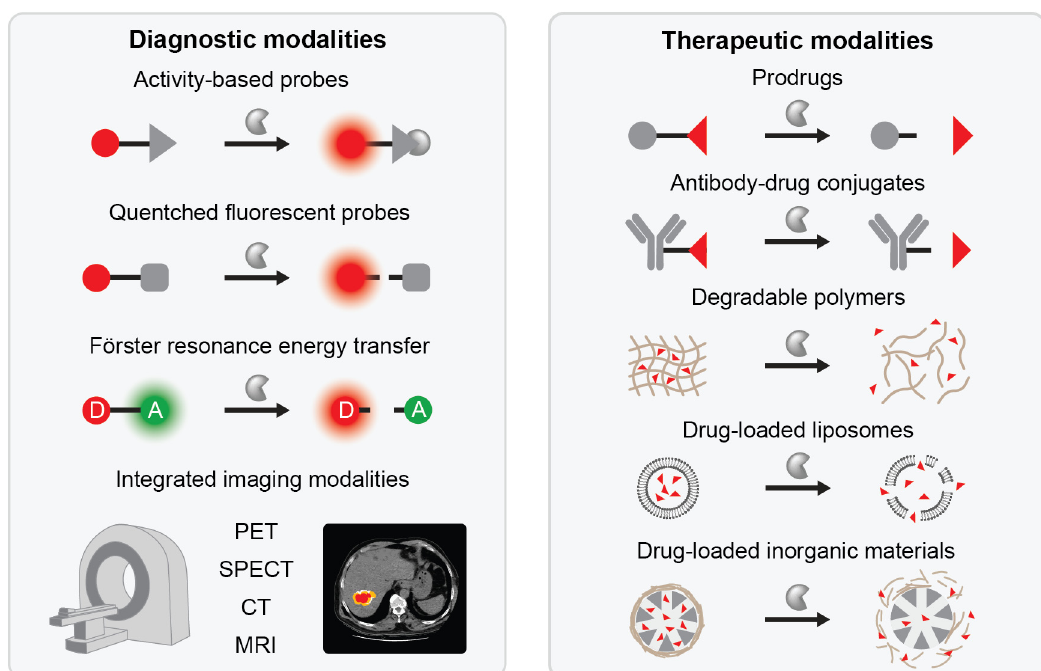
Figure 2. Protease-responsive nanodevices and applications of protease-responsiveness. Protease-responsiveness can be centrally integrated into various diagnostic modalities that utilize optical, MRI, PET, SPECT or CT imaging for detection of protease activity (left). Protease-responsiveness can also serve as a trigger for activation of prodrugs and antibody-drug conjugates or on-site targeting of cancer drugs via polymeric nanoparticles, liposomes and inorganic nanoparticles (right).